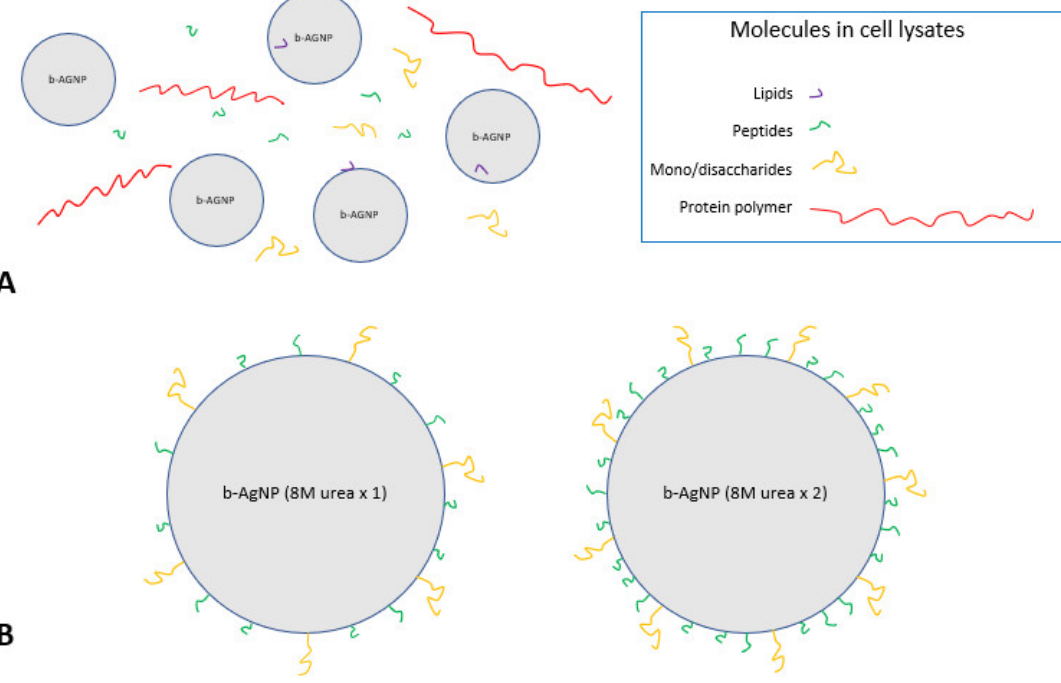
Figure 7. Functionalized Biogenic AgNPs. Theoretical schematic depicting how b-AgNPs treated twice with 8M urea become more thickly coated with small molecules during processing. Panel ( A ) shows b-AgNPs in close proximity to Table 1’s different bacterial molecules in whole-cell lysate debris. Panel ( B ) shows greater functionalization of b-AgNPs (8M urea × 2) with a larger number of soluble molecules (nanoparticles enlarged).